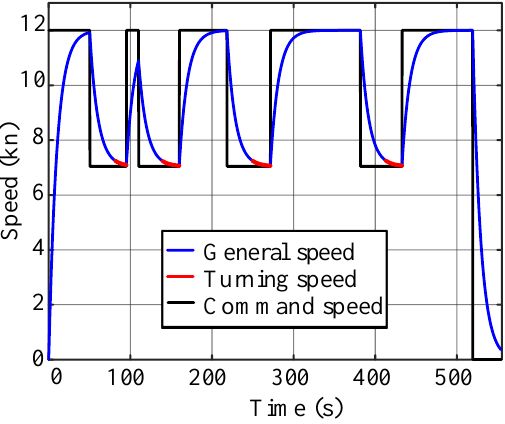
Figure 16. Speed curve of the small-angle turning tracking